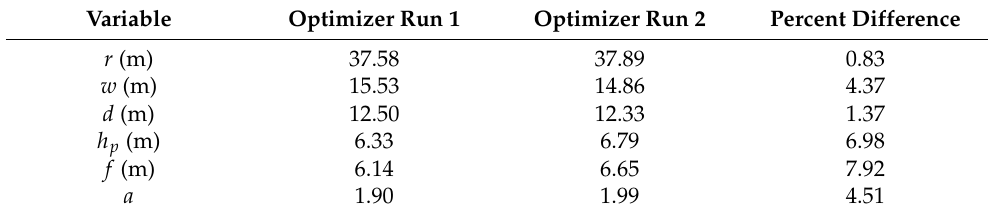
Table 19. Converged values for different optimizer